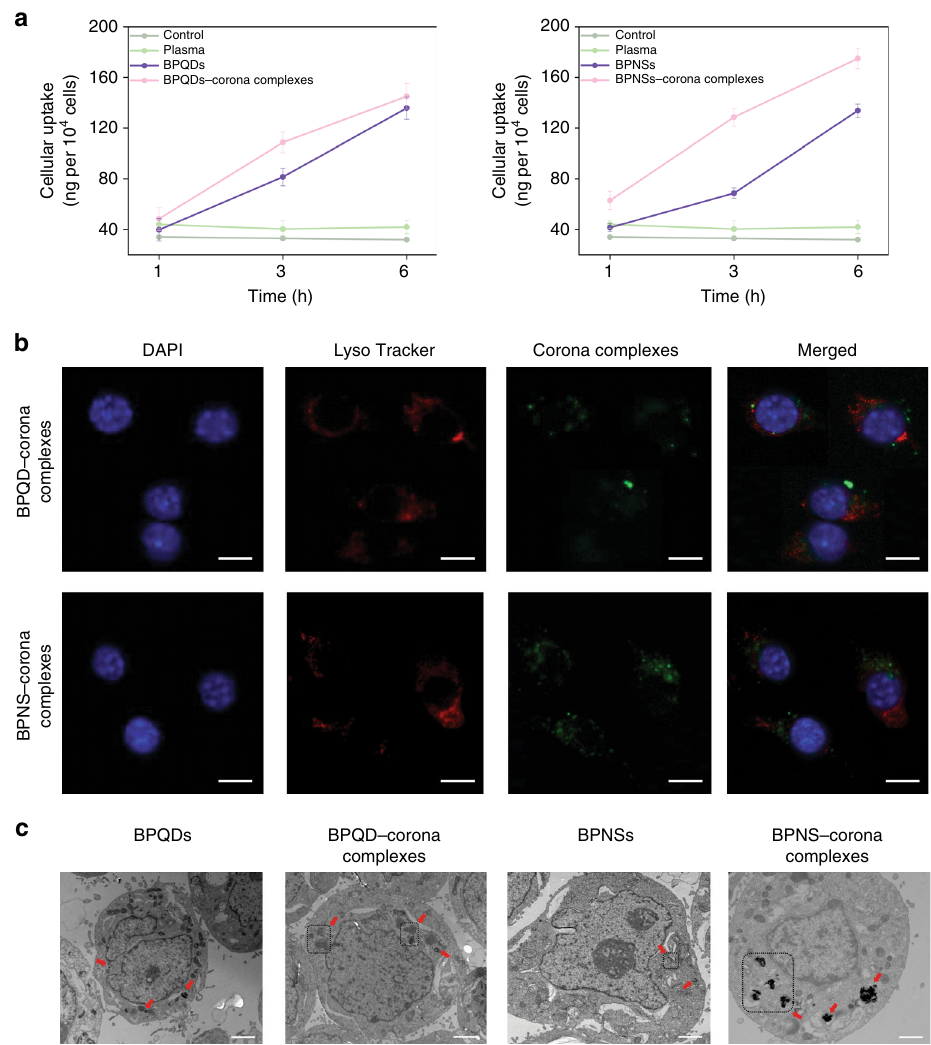
Fig. 4 Cellular internalization of BP nanomaterials and corona complexes. a Cellular uptake of BP nanomaterials and BP – corona complexes. Macrophage- like dTHP-1 cells were treated with 150 μ g ml − 1 nanomaterials for 1, 3 and 6 h. Cells treated with human plasma were set as the control. Values are expressed as the means ± SDs of triplicates. b , c Location of BP nanomaterials and BP – corona complexes in dTHP-1 cells. The cells were treated with 150 μ g ml − 1 BP – corona complexes for 6 h and visualized using b fl uorescence microscopy (scale bar: 10 μ m) and c TEM (scale bar: 2 μ